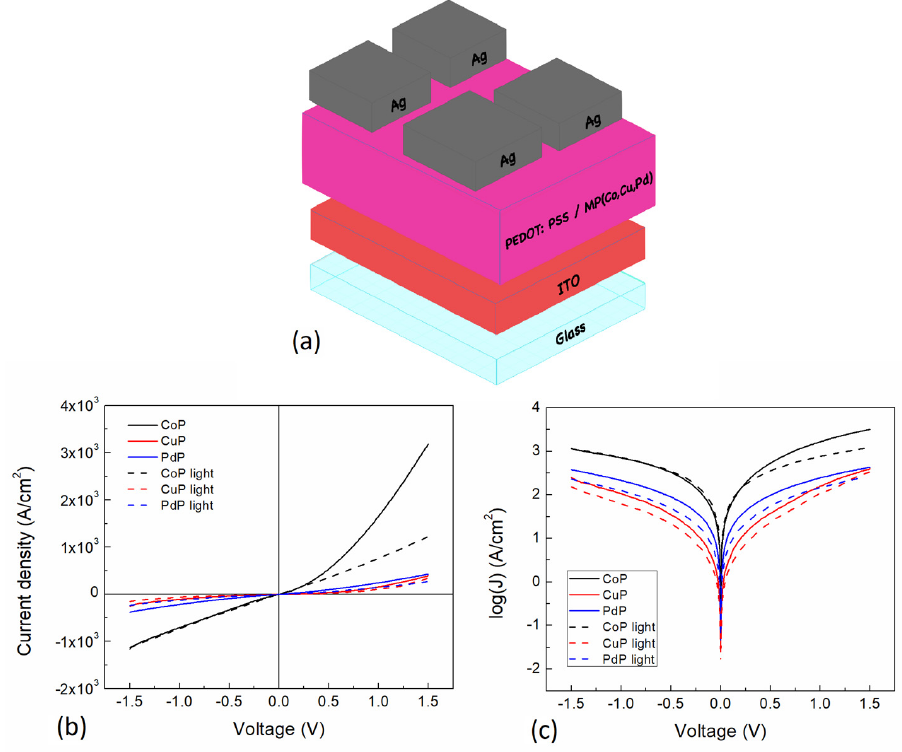
Figure 8. ( a ) Device structure for composite films. ( b ) J-V curves and its ( c ) semilogarithmic curve, for the different porphines under darkness and illuminated conditions.